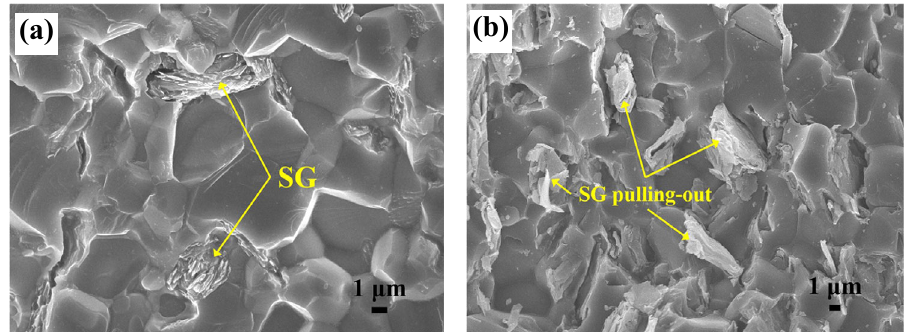
Fig. 10 High-resolution fracture morphologies of 4 wt% SG/AlN composite: (a) with ultrasonic cleaning and (b) without ultrasonic